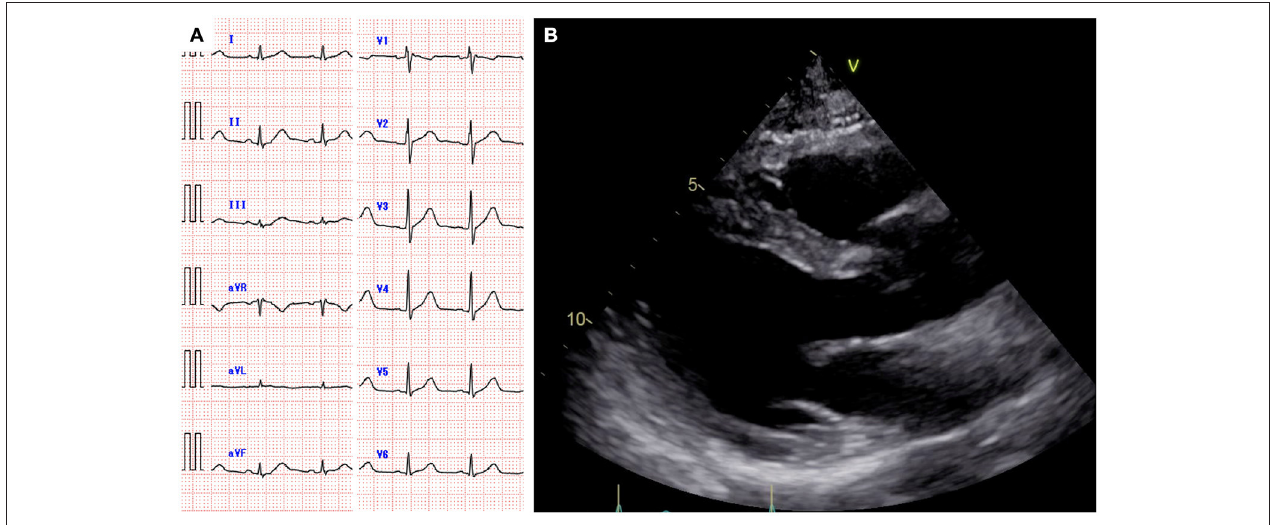
FIGURE 2 | Electrocardiogram showing normal sinus rhythm (A) . Echocardiography showing normal cardiac function and no pericardial effusion (B)